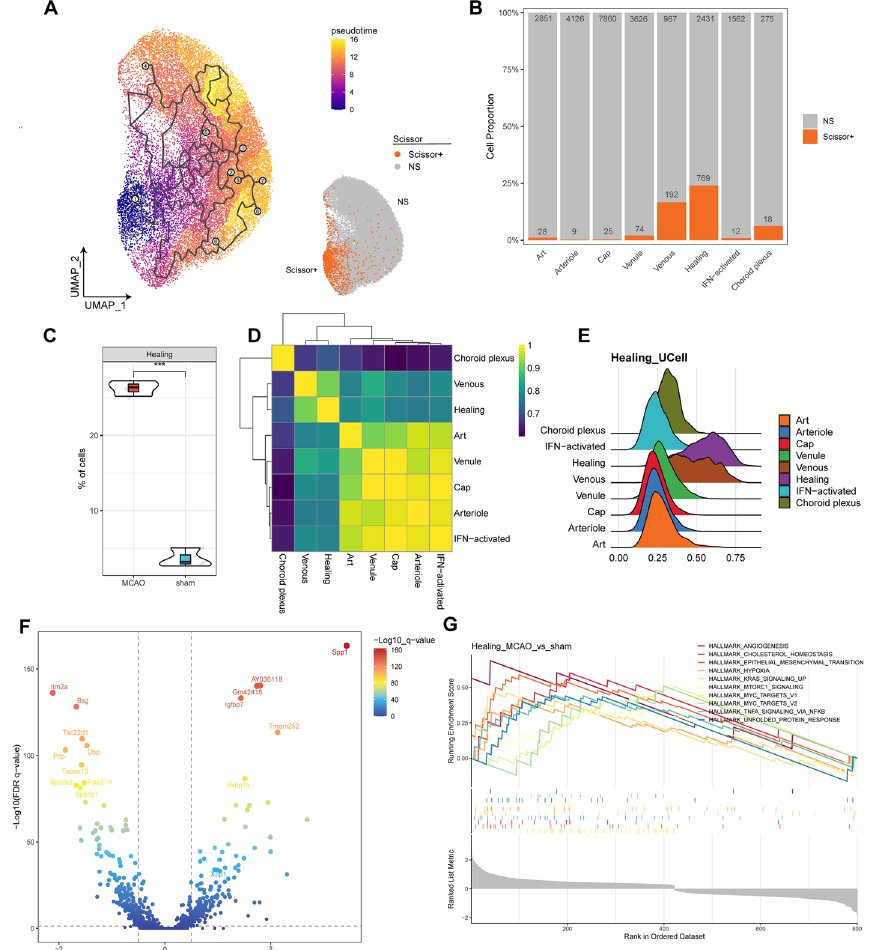
Fig. 2 Identification of healing-state endothelial cell as the major EC subtypes changed under MCAO condition. A UMAP visualization showing the pseudo-time trajectory of the cells (left) and the Scissor-positive (Scissor + ) cells under sham ( n 3) and MCAO ( n 3) conditions (right). Scissor + cells were more relevant to = = MCAO condition compared with NS cells. B Bar plot showing cell proportion in each EC subtype by Scissor results. The number of each cell subtype is labeled. C Violin plot comparing the cell proportions of Scissor + healing ECs under sham ( n 3) and MCAO ( n 3) conditions. Student’s t -test was utilized. *** P < 0.001. D = = Heatmap plot showing the overall expression similarity of each EC subtype. E Ridge plot showing the UCell signature score of healing-state ECs. The UCell signatures of each EC subtype were defined using the top 30 marker genes filtered for FDR < 0.01. FDR false discovery rate. F Volcano plot showing the differentially expressed genes in healing ECs between MCAO ( n 3) and sham ( n 3) conditions. The filter criteria was = = set as FDR < 0.05 and |log 2 FC|> 0.05. FC fold change. G Gene set enrichment analysis showing the